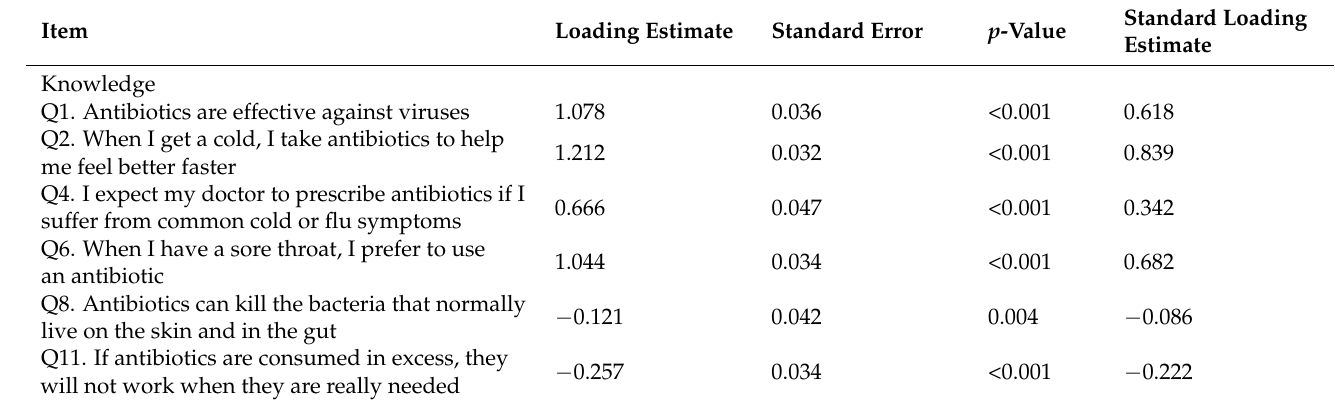
Table 3. Factor loadings and standard errors from the three-factor model of the knowledge and attitude items of the KAP questionnaire on antibiotic